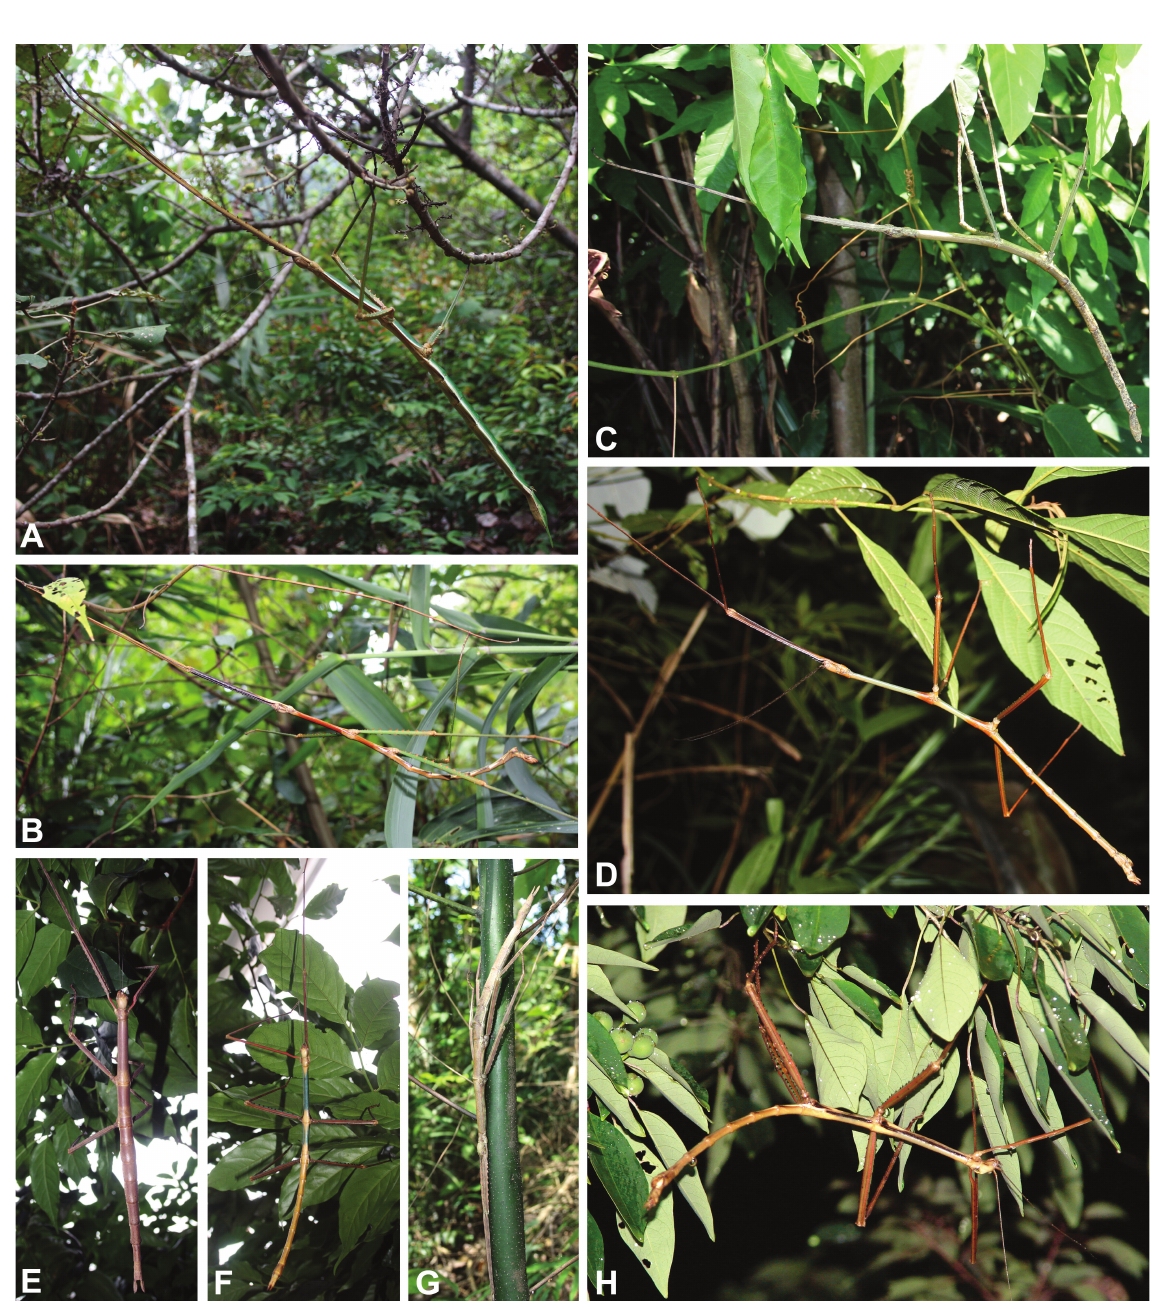
Fig. 10. Phryganistria spp., photographs in natura by the authors. — A–B . P. bachmaensis . A . ♀,